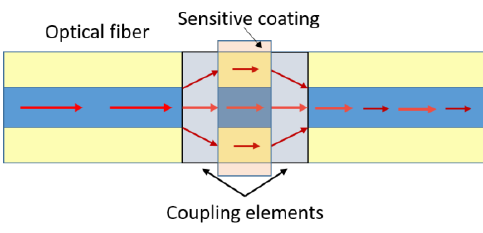
Figure 2. Schematic representation of a MZI-optical fibre sensor.